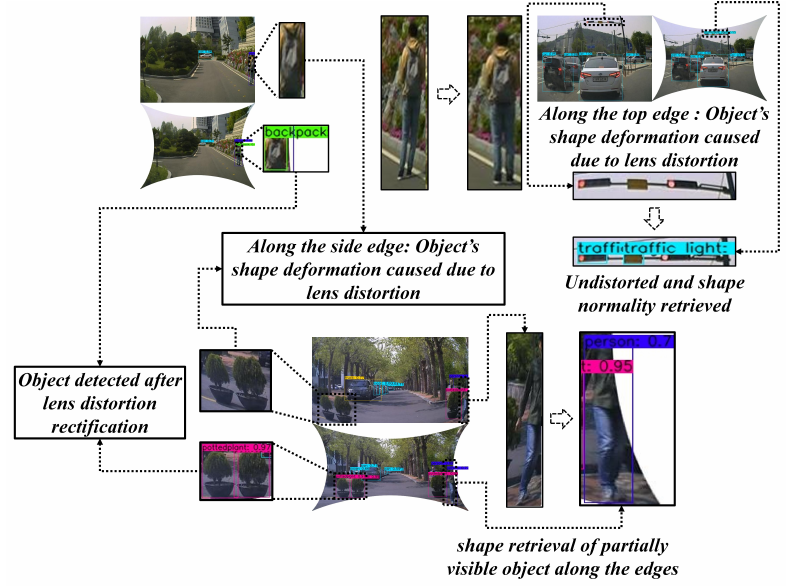
Figure 19. Real-time testing of lens-distortion rectification algorithm on object detection task. Table 6. Percentage of miss-detection instances along the edges due to severe lens distortion which were rectified in the undistortion case.